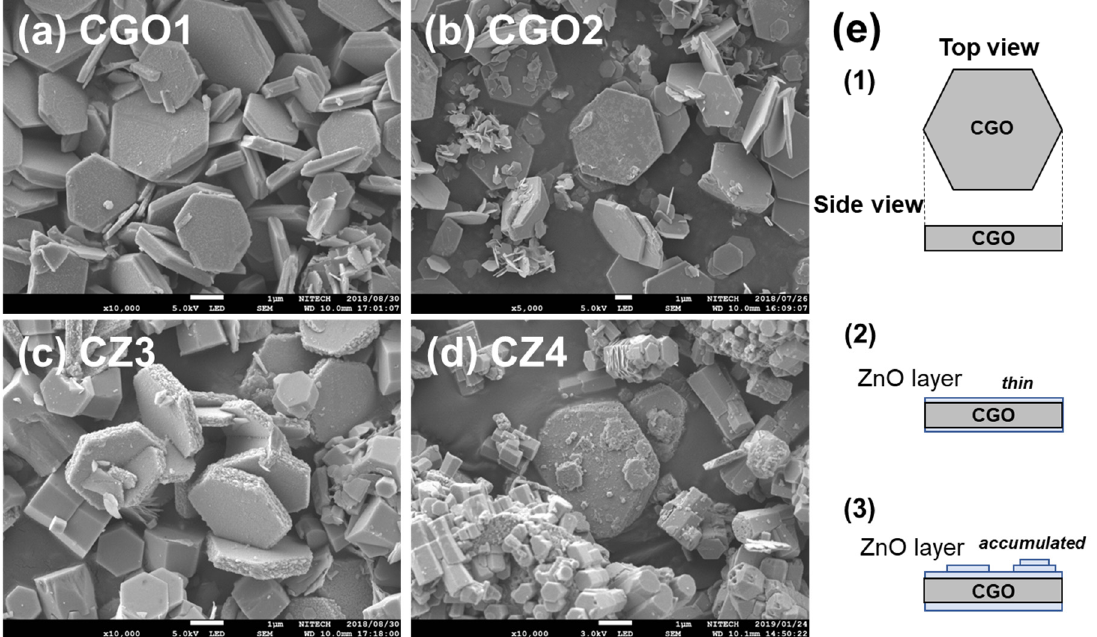
Figure 5. SEM images of the CuGaO 2 base crystals ( a , b ) and CuGaO 2 /ZnO hybrids ( c , d ). CGO1 ( a ) was synthesized with PEG 6000 while CGO2 ( b ) with PEG 20,000. CZ3 ( c ) and CZ4 ( d ) were hybridized with CGO1 and COG2, respectively. The scale bar shows 1 μ m. [Zn]/[Cu] ratio was adjusted for CZ3 and CZ4, as given in Table 1. (See the details in the “Materials and Method” section). SEM images of the CZ1 and CZ2 samples can be found in Figure S5 in the ESI. ( e ) Schematical illustration of ZnO layer on CuGaO 2 (CGO). ( 1 ) bare CGO in top and side views, ( 2 ) CGO with thin ZnO layers, and ( 3 ) CGO with thicker, rather accumulated ZnO layers in side view.